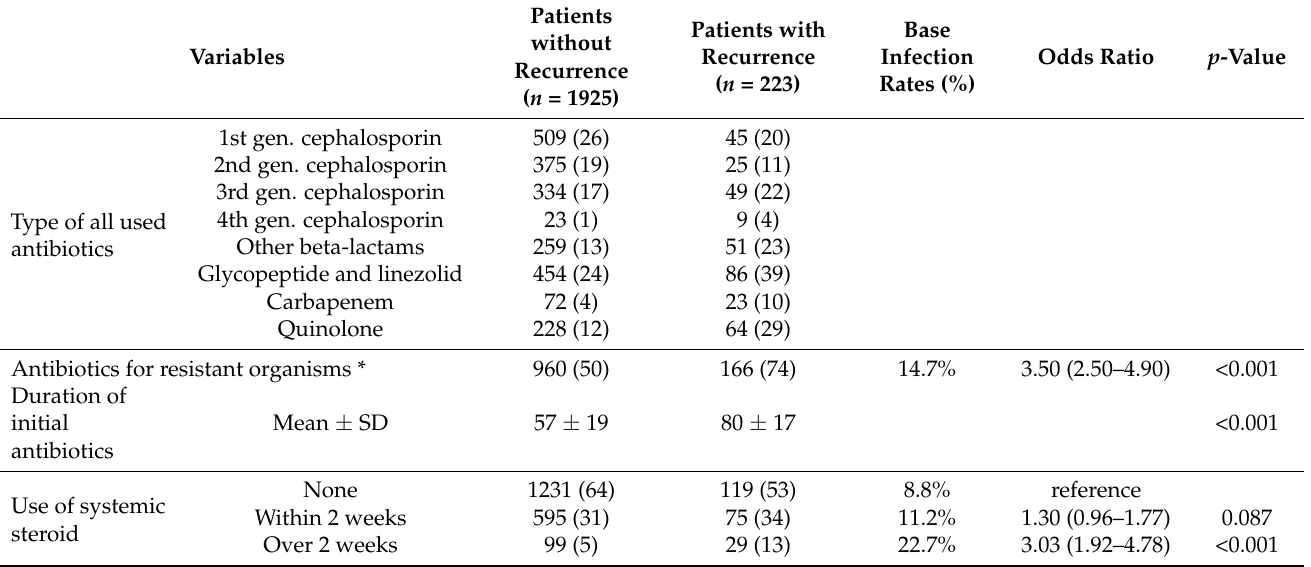
Table 4. Comparison of infection profiles during admission for the index